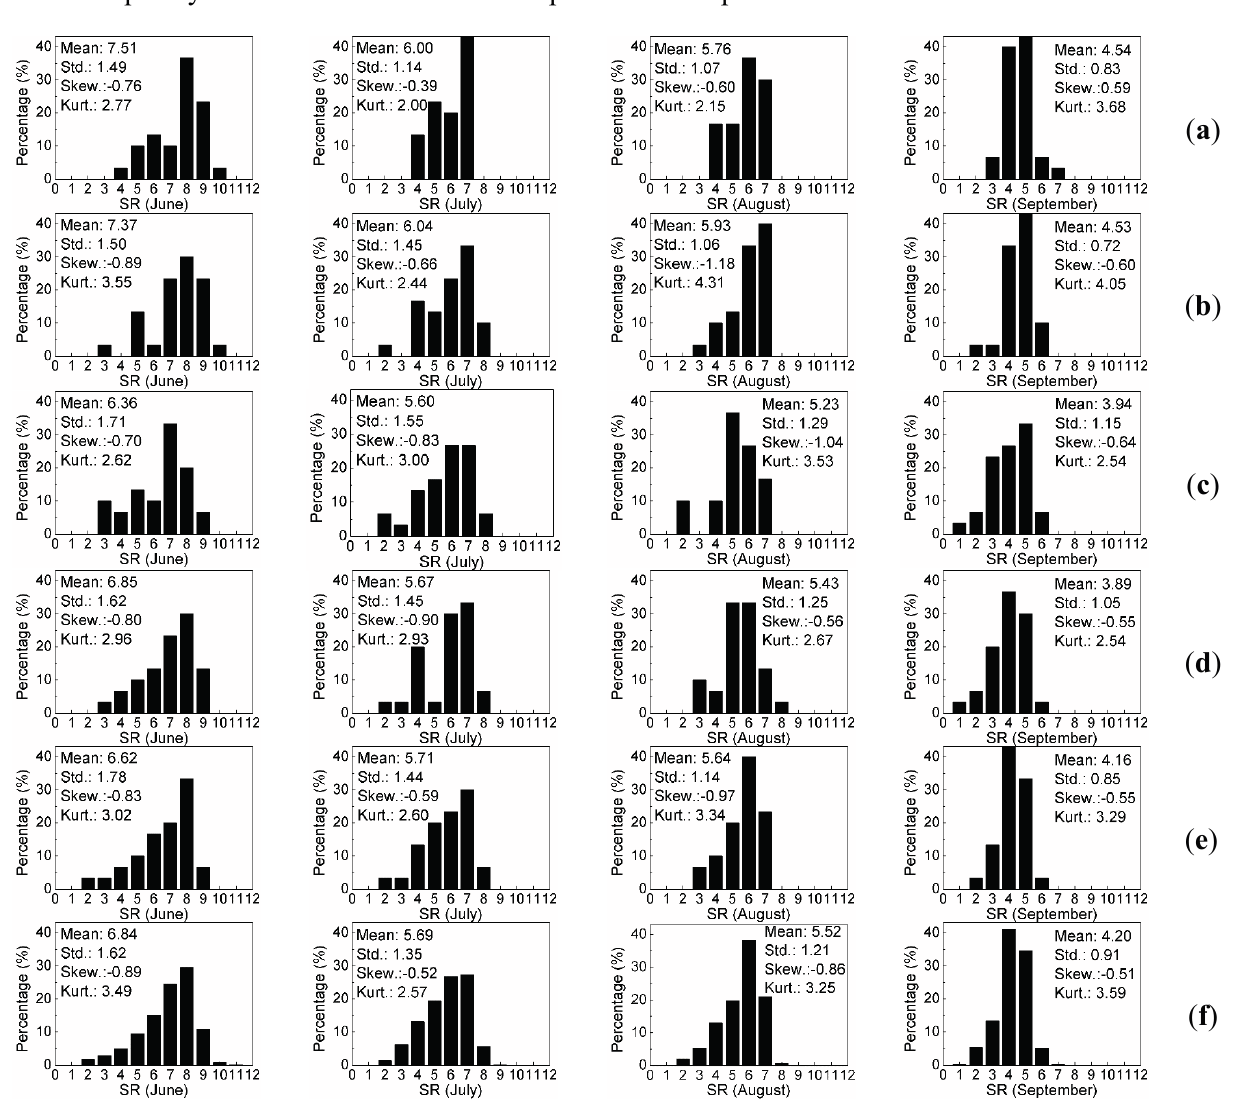
Figure 4. SR frequency distribution histograms for the ESUs selected using ( a ) the random sampling method; ( b ) the systematic sampling method; ( c ) the land-cover map; ( d ) the SSVIP method and ( e ) the SMP method and for ( f ) the entire site from June to September with 30 ESUs. The horizontal axis indicates the SR within the interval [ i − 0.5, i + 0.5], and the four statistical indices are mean (Mean), standard deviation (Std.), skewness (Skew.) and kurtosis